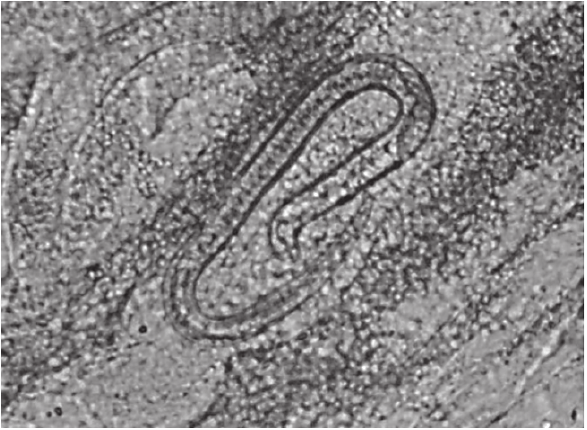
Fig. 1. – Trichinella larvae, detected in one case by